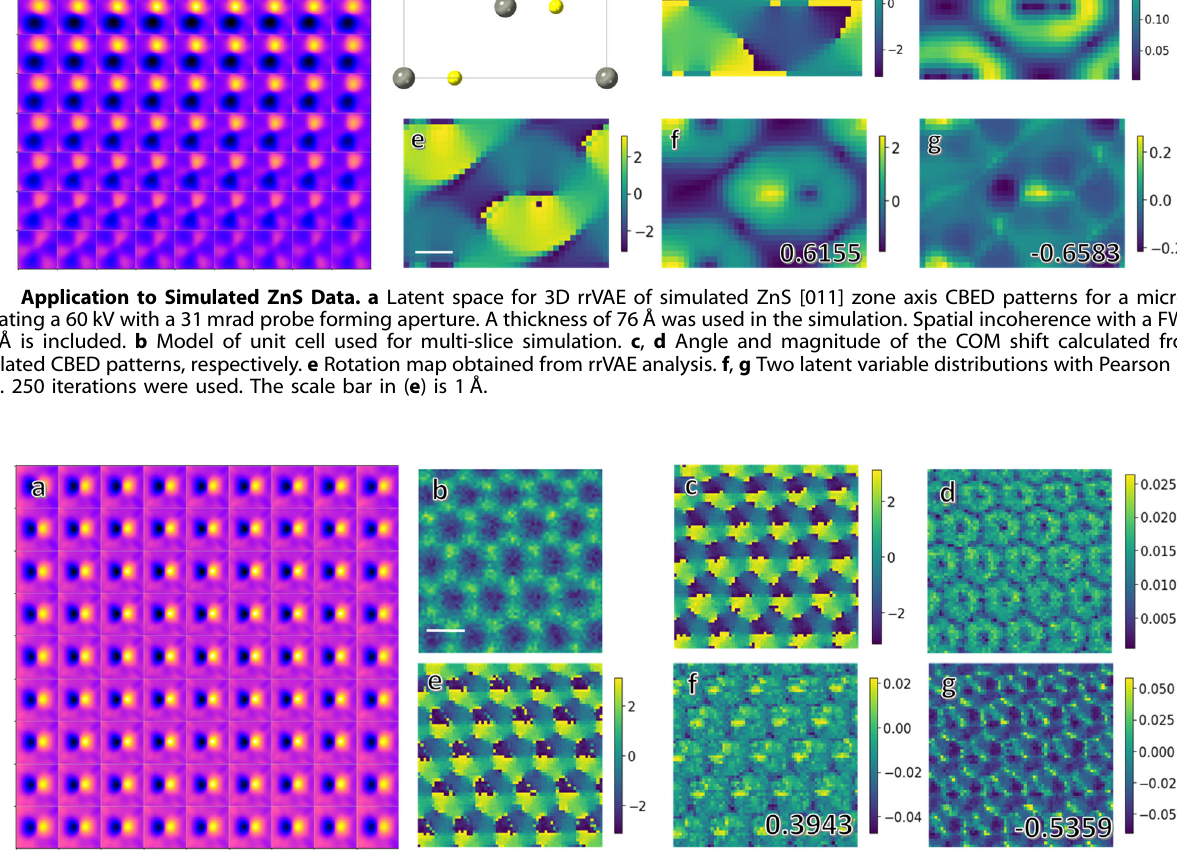
Fig. 5 Application to Experimental Graphene CBED Patterns. a Latent space for 3D rrVAE for experimental graphene CBED patterns with the microscope operating a 60 kV with a 31 mrad probe forming aperture. b Simultaneously acquired ADF-STEM image. c , d Angle and magnitude of the COM de fl ection calculated from the experimental CBED patterns, respectively. e Rotation map obtained from rrVAE analysis. f , g Two latent variable distributions with Pearson r factor inset. 75 iterations were used. The scale bar in ( b ) is 2 Å.